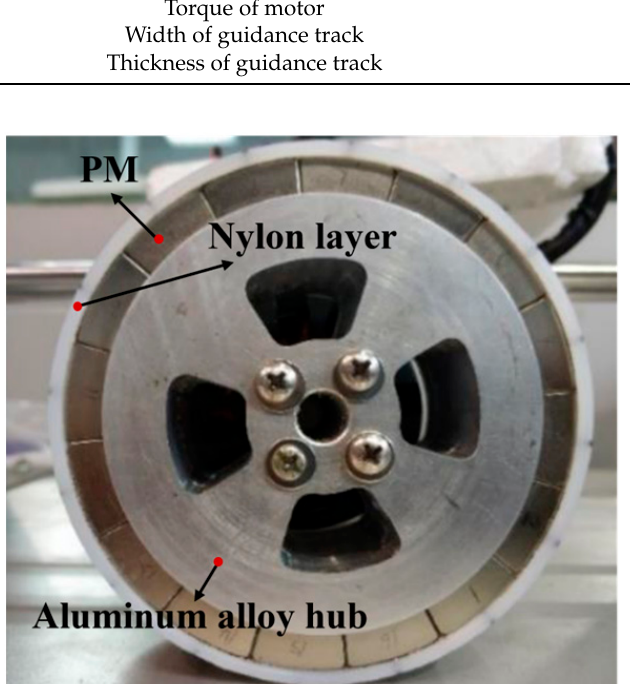
Figure 20. The experimental results of normal attraction force and guidance force at different work- ing gaps.